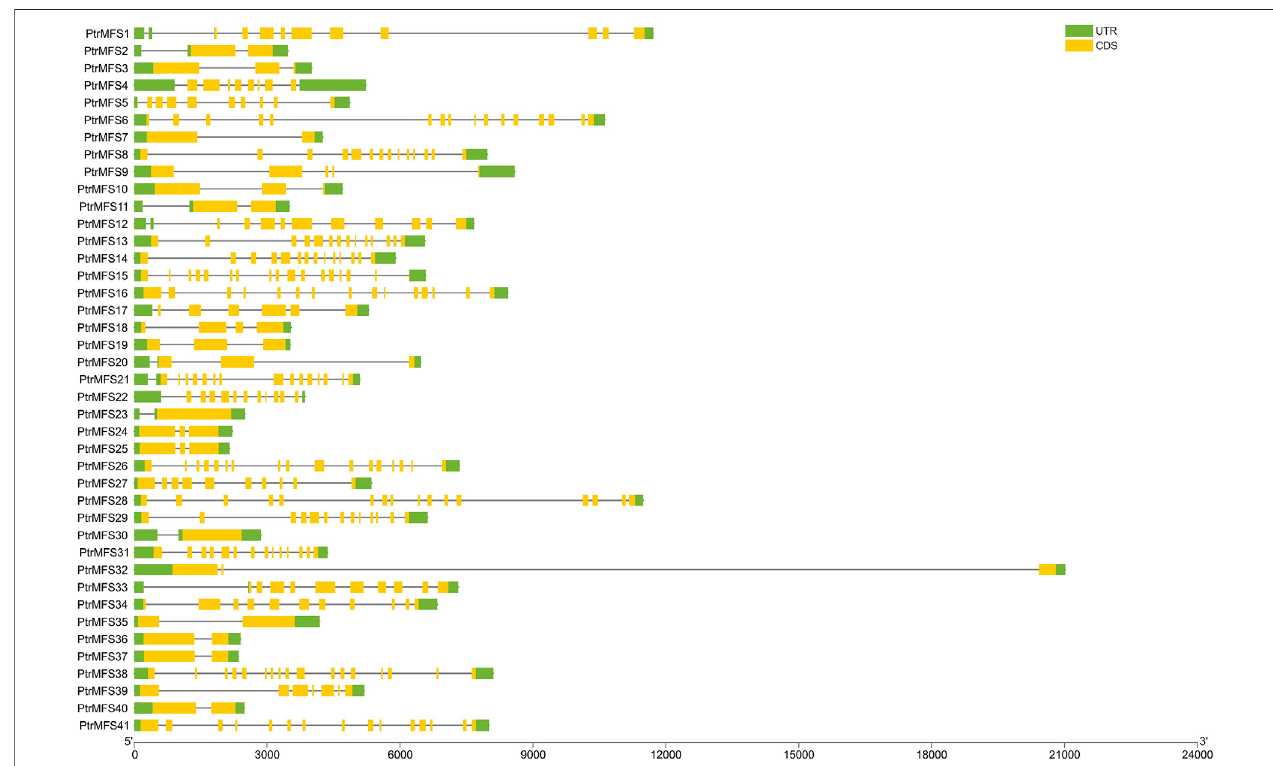
FIGURE2| DNAstructuresof PtrMFS genefamilyinpoplar.Greenboxesrepresentuntranslatedregions.Yellowboxesdenotecodingregions.Blacklinesindicate introns.